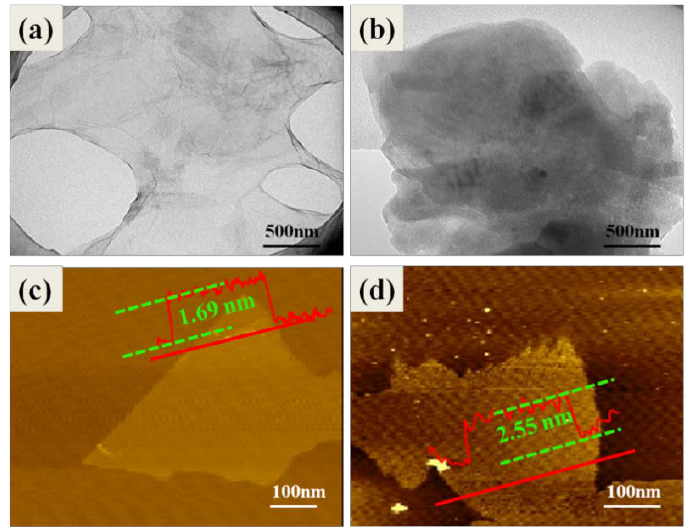
Figure 3. TEM images of ( a ) GO and ( b ) GL- g -LMPET; AFM image of ( c ) GO and ( d ) GL- g -LMPET.